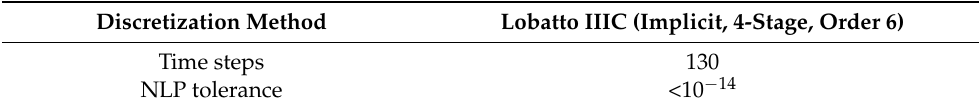
Table 3. Bocop settings used in Section 5.